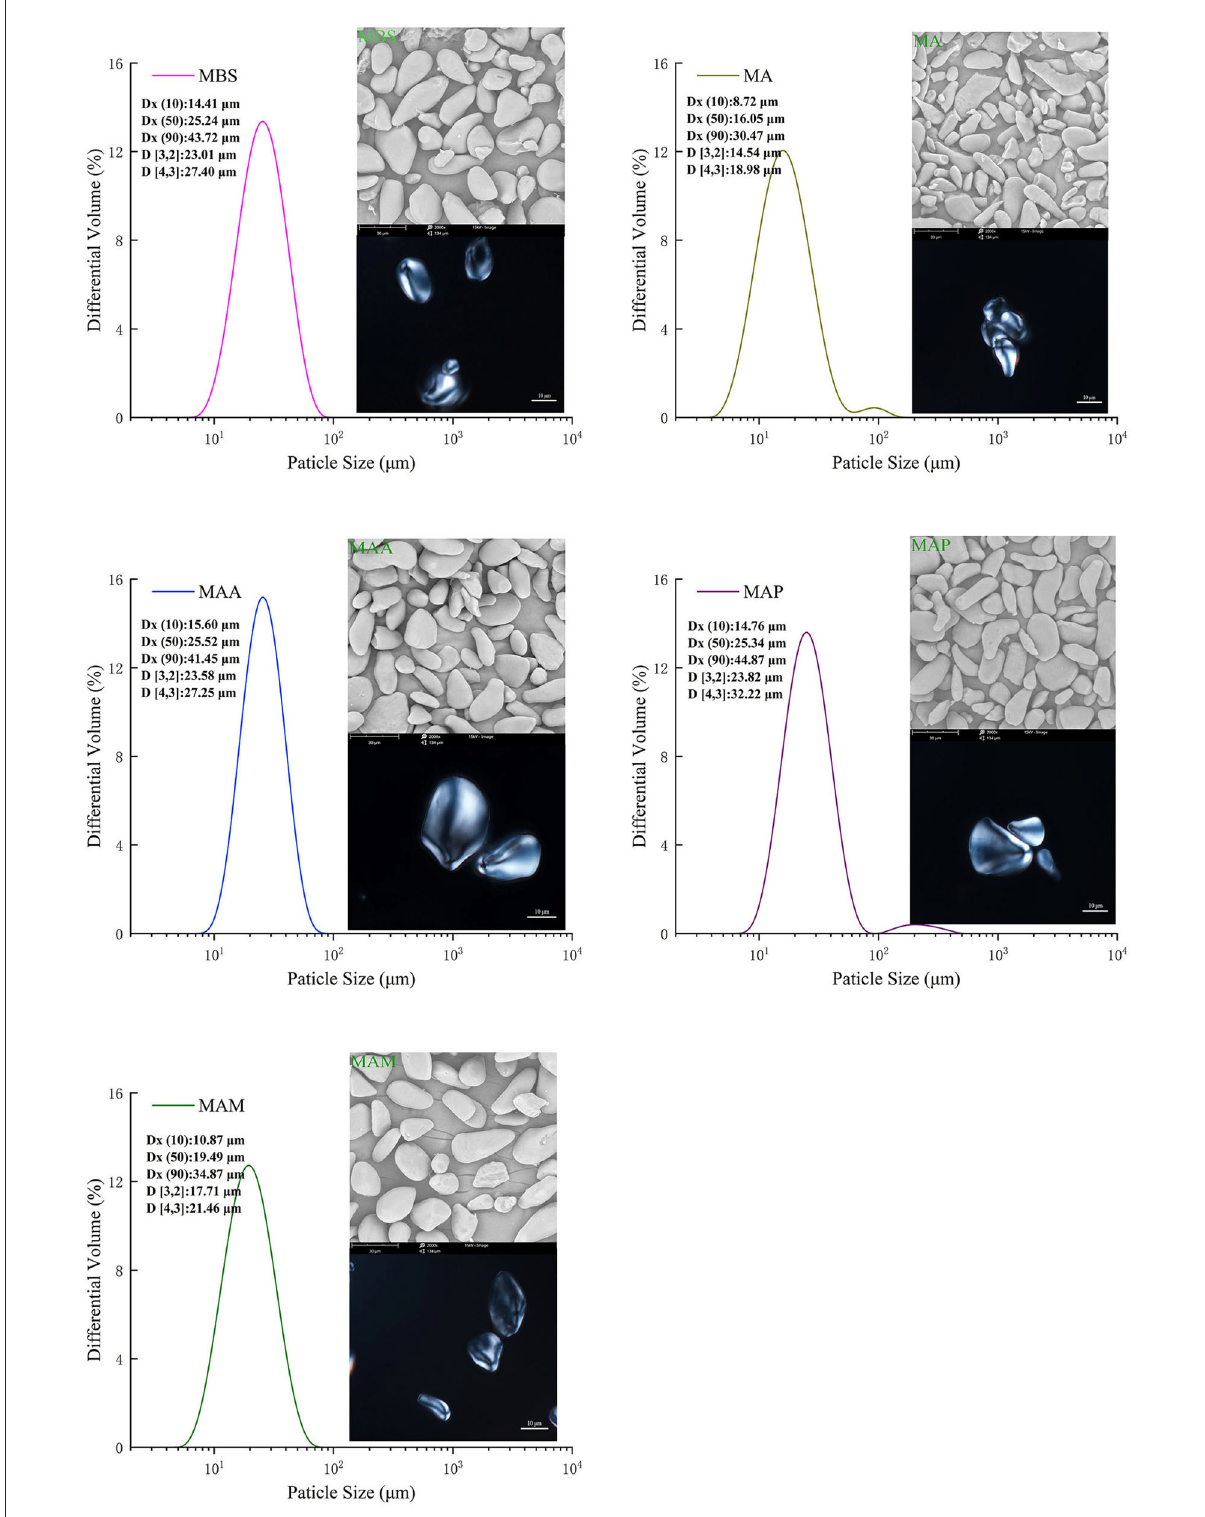
FIGURE2 Particle size and distribution, and microscopy of starch granules at 2,000 × magnification (SEM) and visualized with a polarized light